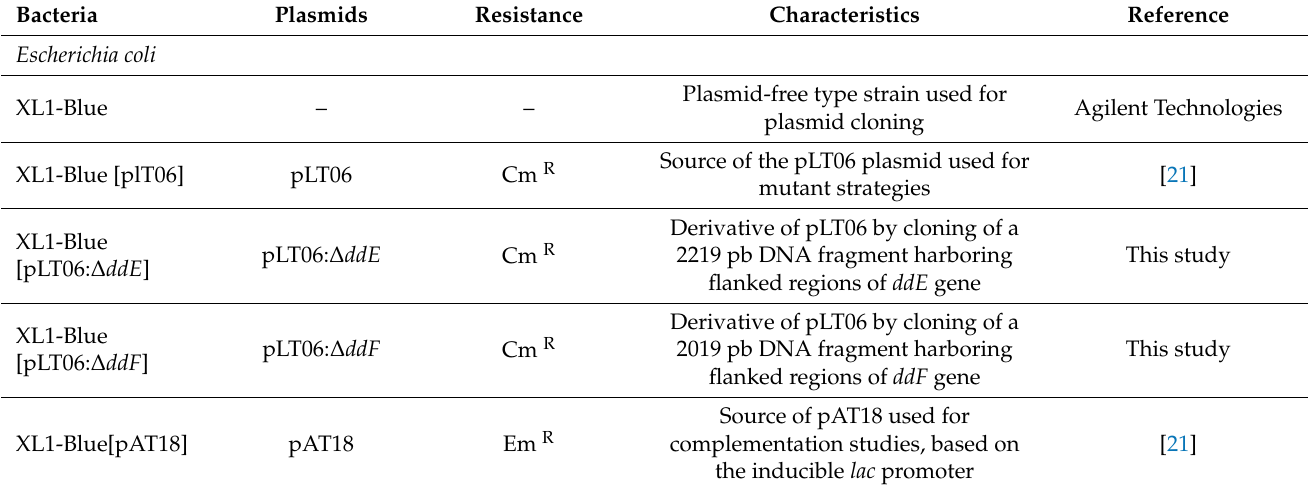
Table 4. List of the bacteria used in this